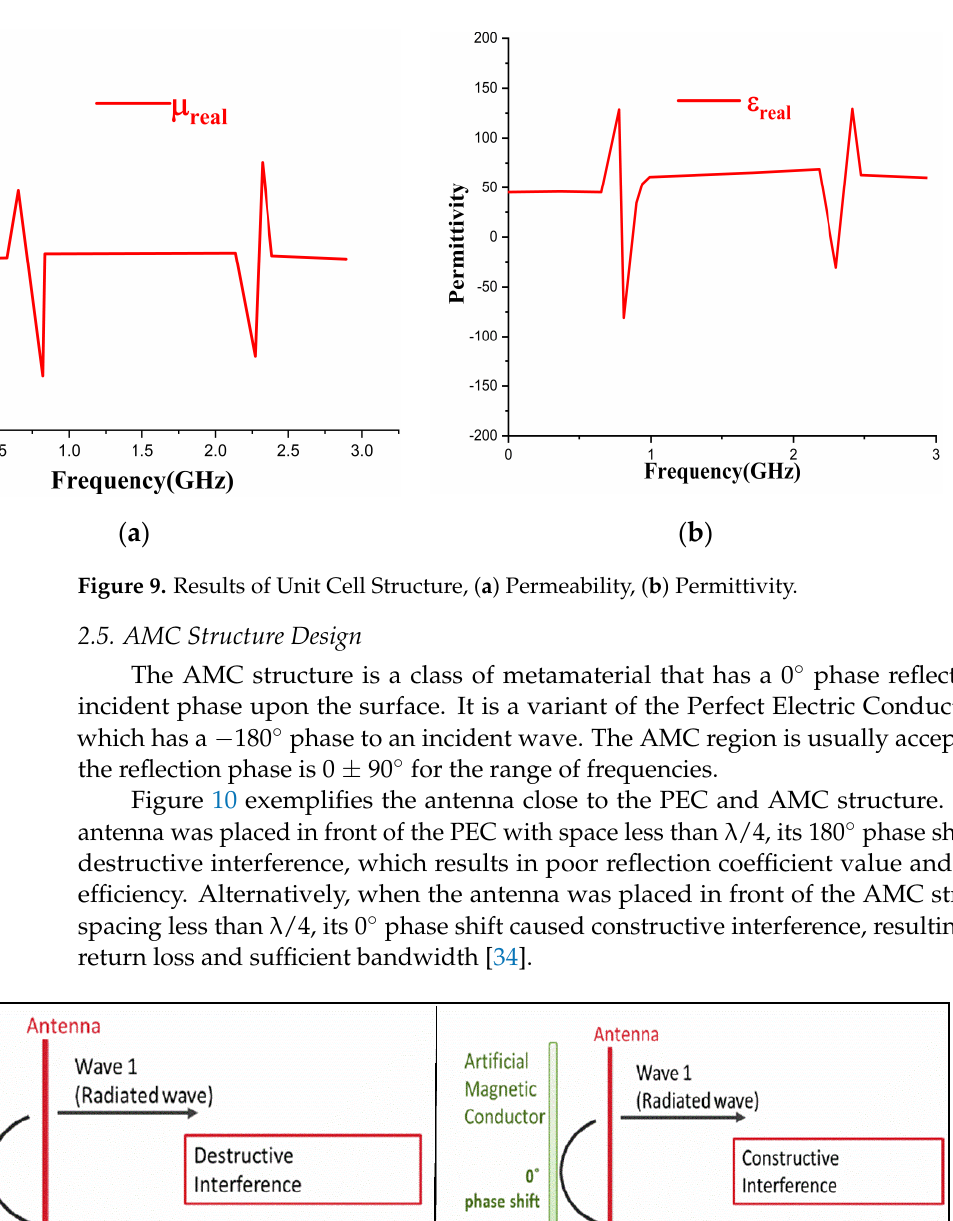
Figure 10. An Antenna placed flat against the PEC and AMC.